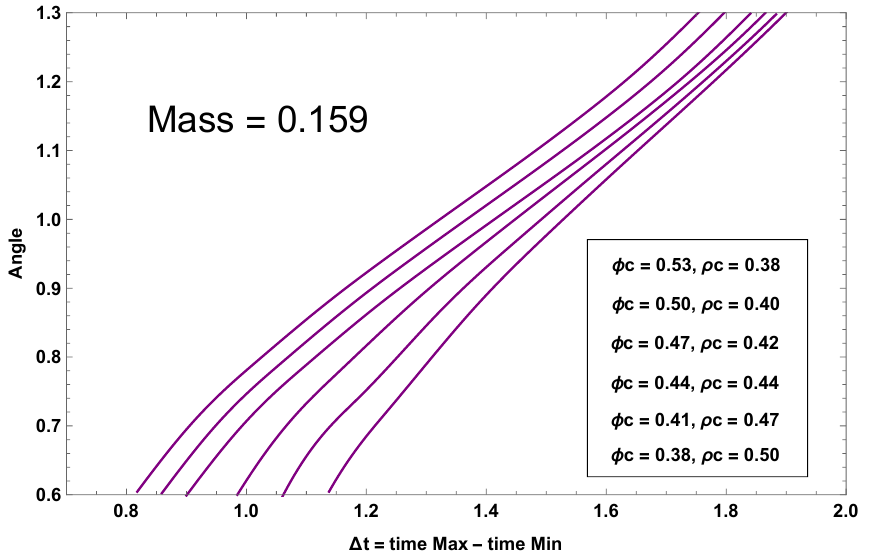
Figure 6. Close-up to the plot of the angle (cid:12) vs (cid:1) t for solutions with di(cid:11)erent values of (cid:26) c and (cid:30) c , and total mass M Total = 0 : 159.